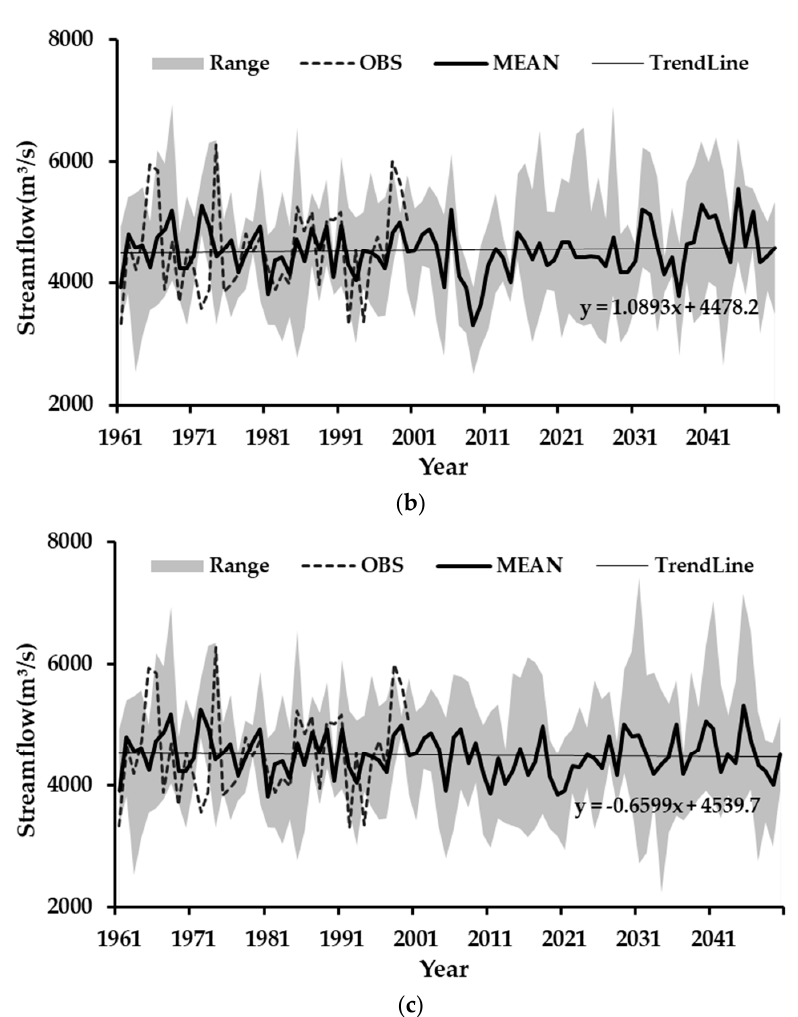
Figure 9. Annual streamflow in Pingshan Station under different scenarios: ( a ) RCP2.6, ( b ) RCP4.5, and ( c ) RCP8.5. Table 7. Annual streamflow (m 3 /s) of Pingshan station in typical years.